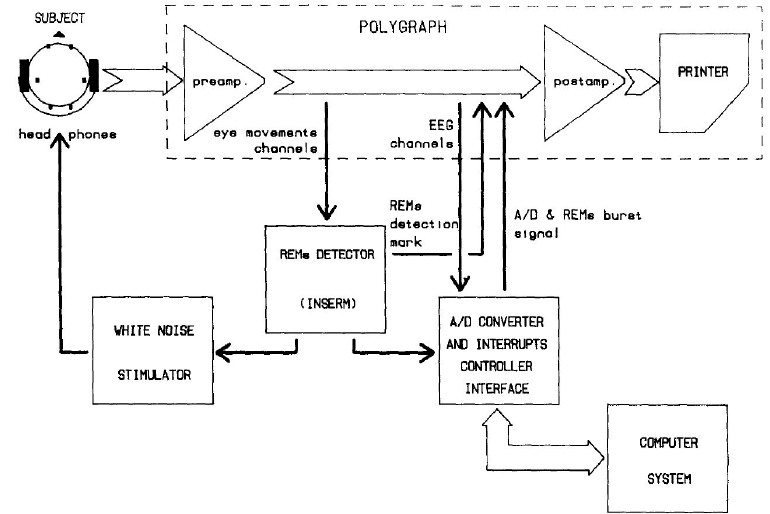
Figure 2. The first illustrative figure on close-loop feedback in Mouze-Amady et al. [49] This diagram demonstrates the feedback loop which is indispensable for closed-loop feedback system. demonstrates the feedback loop which is indispensable for closed-loop feedback